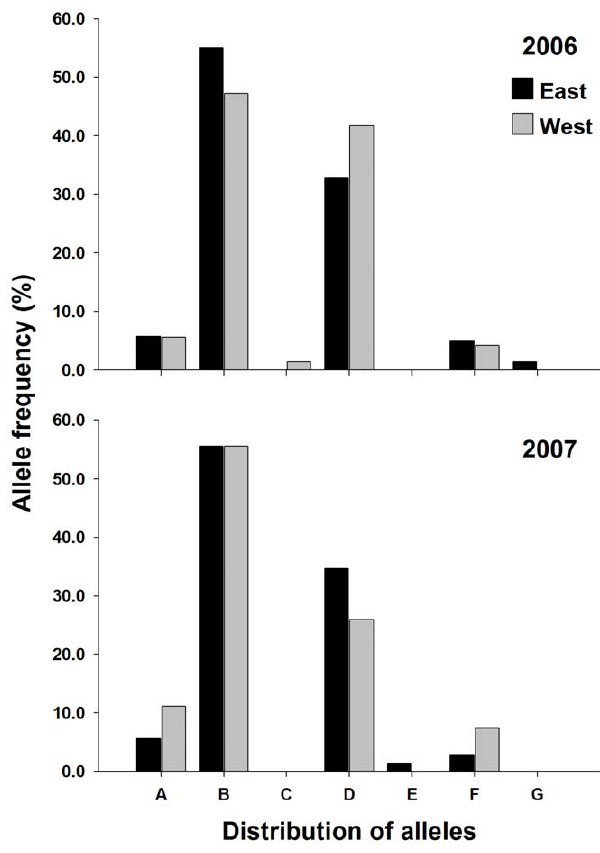
Figure 7. Distribution of alleles for microsatellite locus AG7 in 2006 and